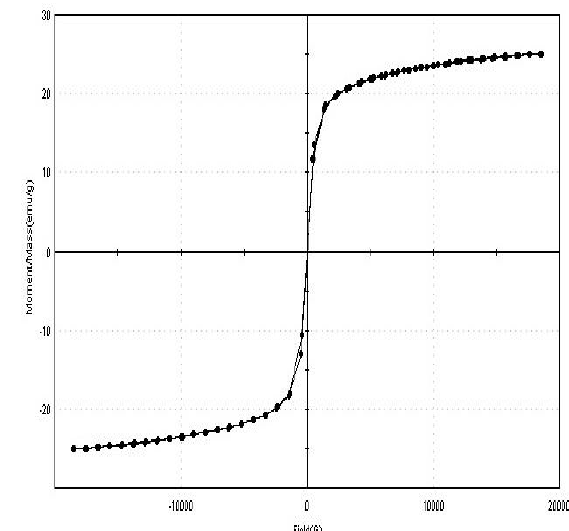
Figure 2.Vibrating sample magnetometer (VSM) curve of MCh/Fe-Zr nanoparticles Examining the X-ray Diffraction Spectrum The crystal structure of MCh composite is presented in figure 3. XRD patterns indicated certain peaks for MCh at 2θ, 30.313 (2 2 0), 35.707 (3 1 1), 43.401 (4 0 0), 53.85 (4 2 2), 57.41 (5 1 1), 63.05 (4 4 0), 75.64 (6 2 2), 32.155 (0 1 1), 36.613 (6 1 1), 57.33 (0 3 0), and 63.17 (18 1 1). This is in agreement with data presented by the Inorganic Crystal Structure Database (ICSD). XRD indicated that modification of chitosan-zirconium on magnetic nanoparticles has no effect on Figure 1. Fourier transform infrared changing the phase of Fe 3 O 4 . The results also spectroscope (FTIR) spectrum of composite of indicated high crystallization of MCh/Fe-Zr MCh/Fe-Zr nanoparticles nanoparticles. Examining the Magnetic Properties of Composite of MCh/Fe-Zr Nanoparticles Examining Scanning Electron Microscope Images Vibration sample was examined at room temperature to examine the magnetic The shape and size of MCh/Fe-Zr of MCh nanoparticles using nanoparticles composite were determined magnetometer. Magnetic moment in using SEM. Figure 4 illustrates SEM images magnetic field in 300 K for MCh is presented of the nanoparticles that have irregular shapes, spherical particles of Fe 3 O 4 attached to the surface of the MCh-Zr particles with saturation is 25.037. The synthesized high density, and the size of the synthesized nanoparticles ranging from 31.9 to 140.4